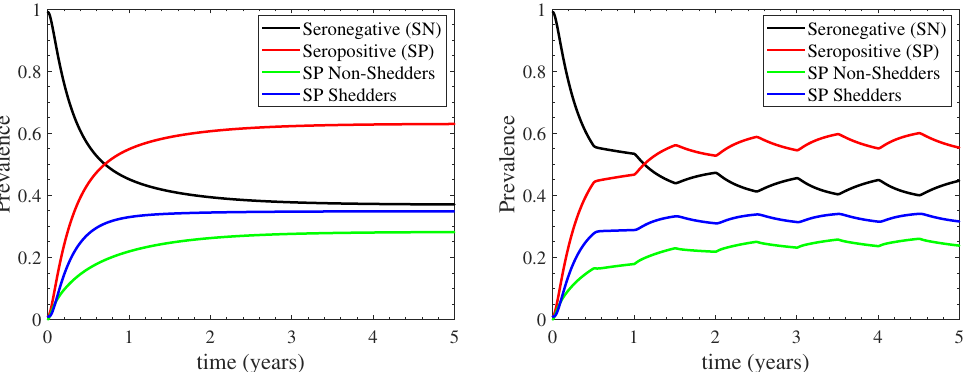
Figure 3. Prevalence of seronegative (SN, S np + E np + S mp + E mp ) and seropositive (SP, A np + A mp + I mp ) cattle, with the seropositive ones being either non-shedders ( A np + A mp ) or shedders ( I mp ). Both continuous ( left ) and seasonal ( right ) housing are considered; in the latter case the herd remains indoors/outdoors during the first/second half of each